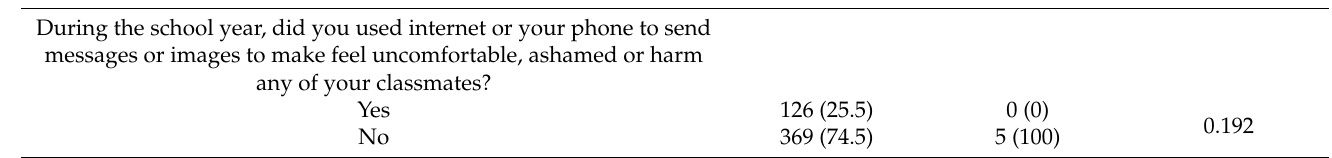
Table 3. Univariate analysis of COVID 19 self-test practice for students aged 16–18 y.o.